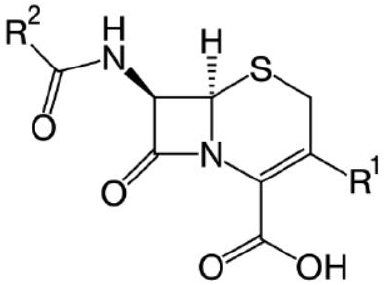
Figure 1. Structural formula of cephalosporins.